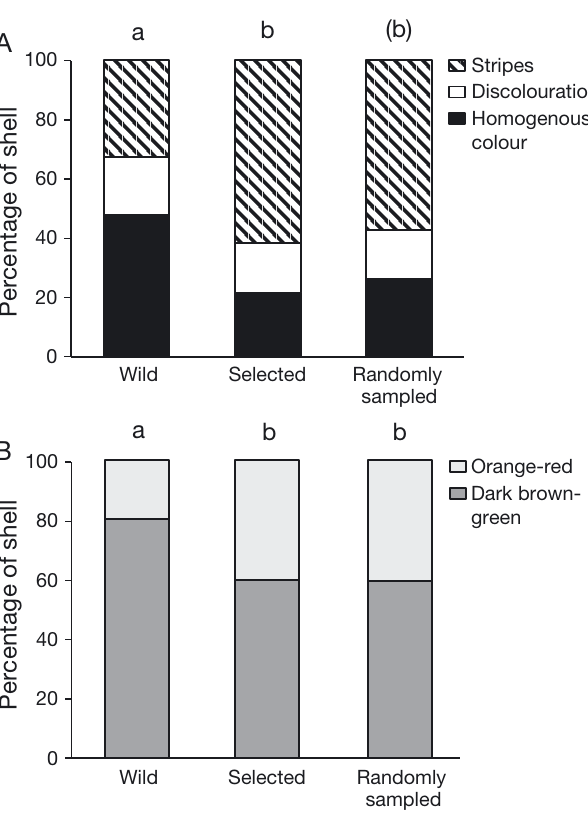
Fig. 3. (A) Shell pattern and (B) shell colour of offspring from 3 different abalone Haliotis tuberculata broodstock origins (wild, farmed selected on weight and farmed randomly sam- pled) (n = 42 abalone minimum treatment −1 , n = 148 in total, Pearson’s chi-squared test). Values with different letters ‘a’ and ‘b’ differ (p < 0.05). Values with letters within parenthe- sis (b) tend to differ from values with letters ‘a’ (p <